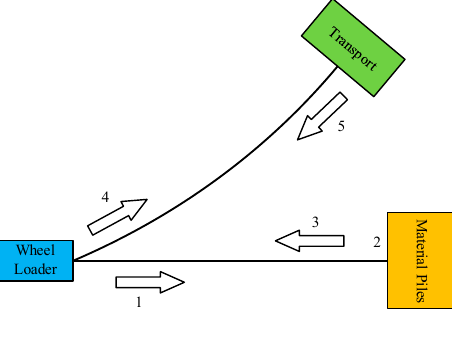
Figure 2. V-cycle of wheel loader.